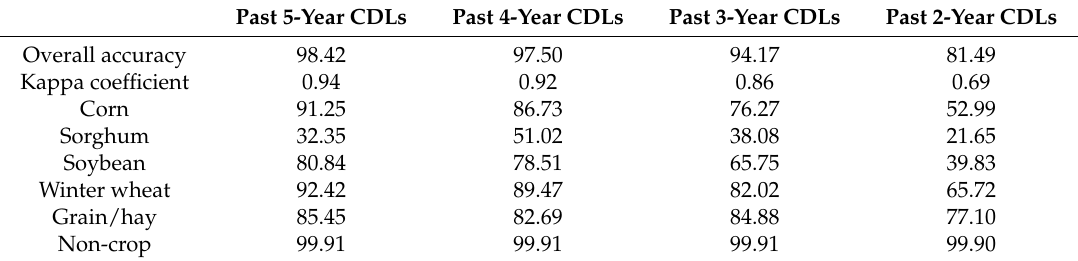
Table 7. Accuracy of rule-based class labels for four different past CDL combination